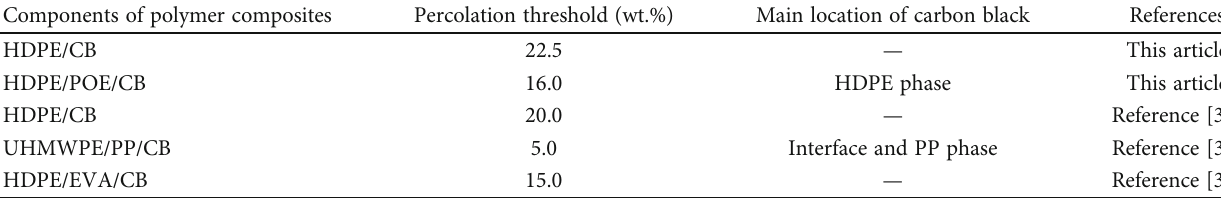
Table 1: The comparison of percolation threshold and fi ller distribution of di ff erent polymer composites. Components of polymer composites Percolation threshold